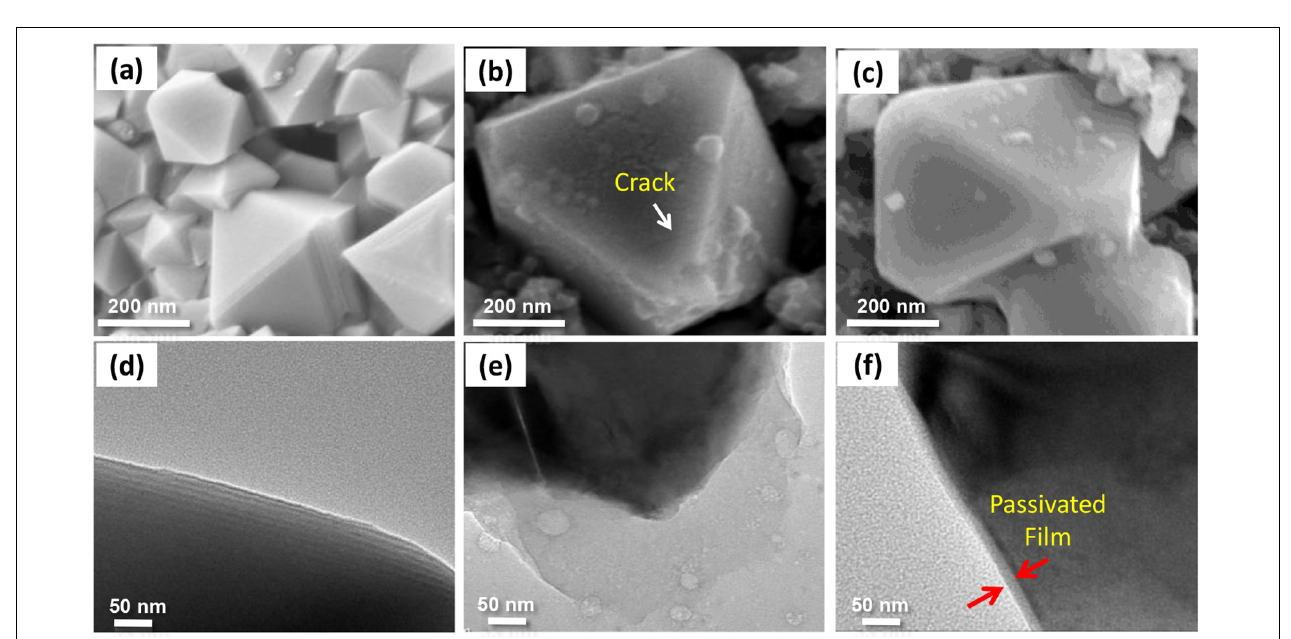
FIGURE 6 | SEM images of pristine graphite anode (a,d) and the anodes cycled in the electrolyte without (b,e) , with 5 wt.% PS (c,f) .